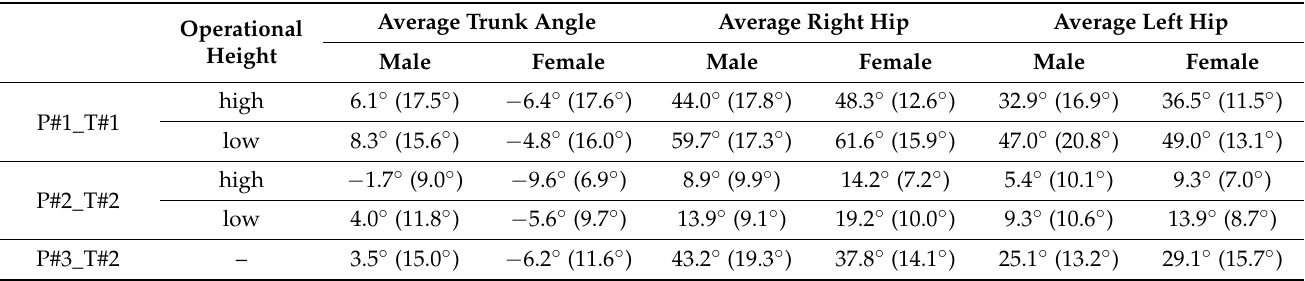
Table 3. The estimated joint angles at each of the specific postures. The results are presented as the mean value (standard deviation).